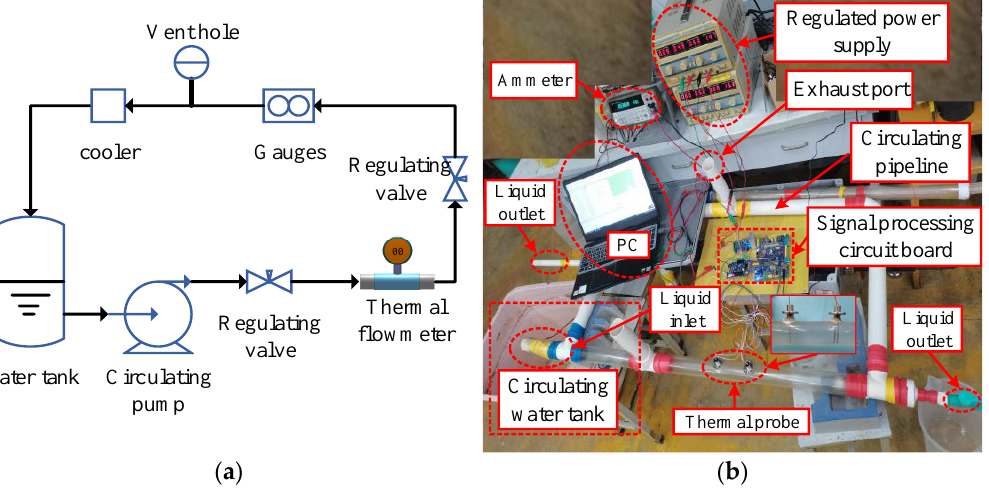
Figure 5. Experimental environment. ( a ) Schematic diagram of experimental circulation system. ( b ) Construction chart of experimental circulation system.